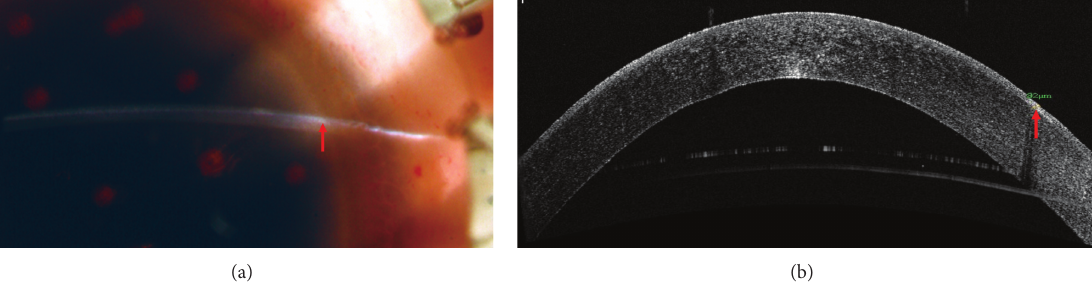
Figure 2: (a) What appears to be anterior stromal pathology as visualized by slit lamp microscopy. (b) FD-OCT evaluation reveals that scarring is limited to the corneal epithelium. The arrow indicates the location of opacities.